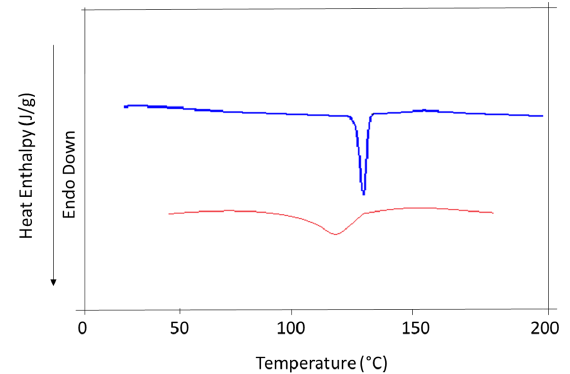
Figure 3. DSC thermograms of unprocessed (raw) and nanocrystals.